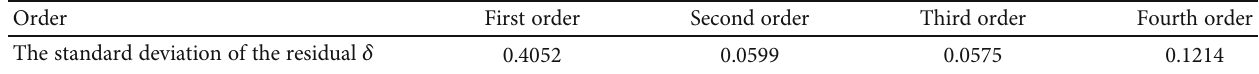
Table 1: The standard deviation of the residual between the measured data and the predicted data. Order The standard deviation of the residual